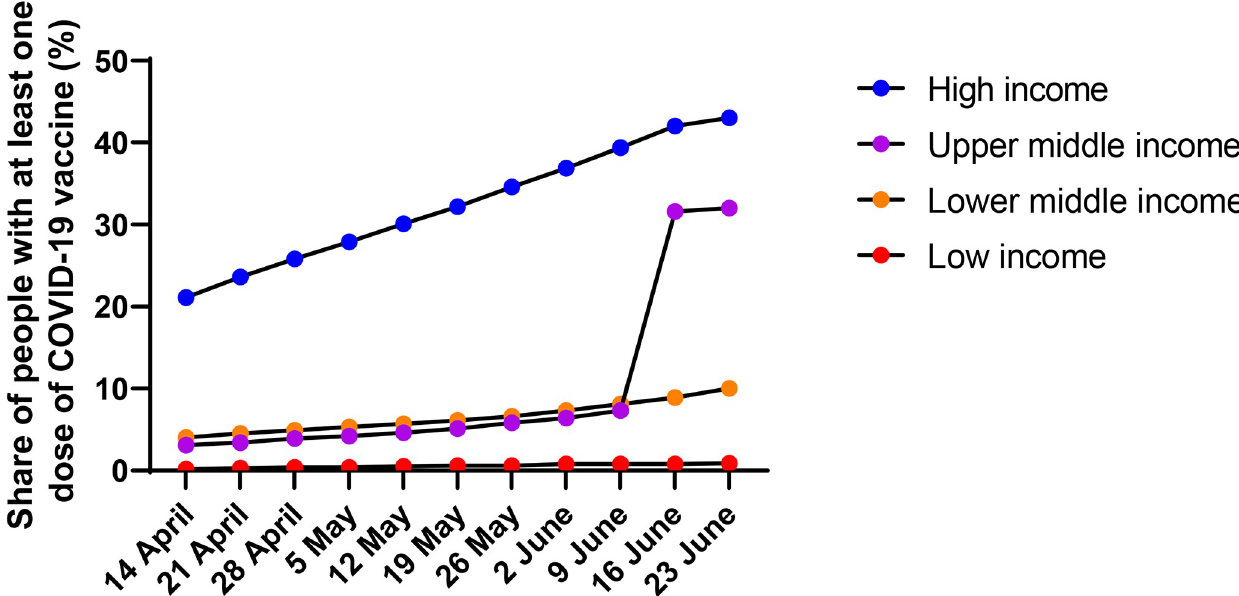
Fig 1. Proportion of people vaccinated with at least 1 dose of COVID-19 vaccine by income (April 14 to June 23, 2021). Note: Data on China appeared on the database on June 9, hence the jump in upper middle-income countries. COVID-19, Coronavirus Disease 2019. Source : https://ourworldindata.org/ covid-vaccinations